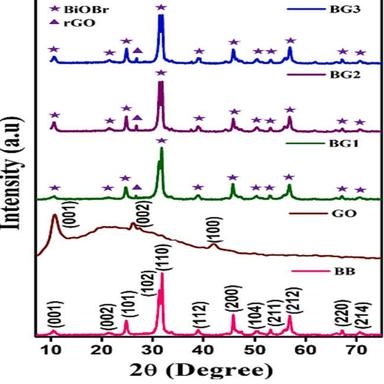
XRD pattern of prepared BB, GO, BG1, BG2 and BG3 nanomaterials.